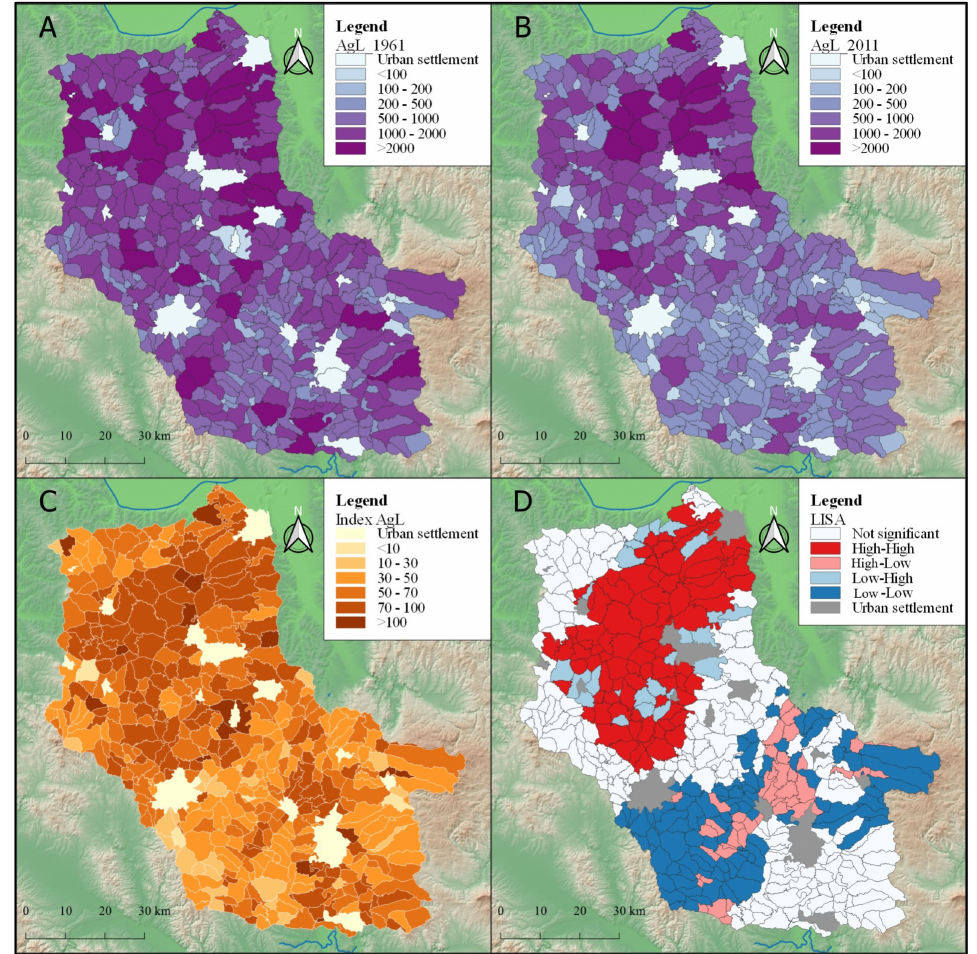
Figure 3. Agriculture land ( AgL ) in rural settlements of the Velika Morava River Basin in 1961 ( A ) and 2011 ( B ); Index AgL for the period of 1961–2011 ( C ); LISA univariate cluster map of Index AgL for the period of 1961–2011 ( D